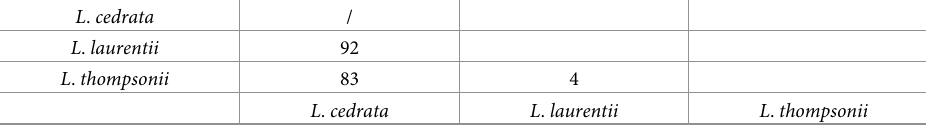
Table 10. SNP variation in plastid CDS regions among Leplaea species.